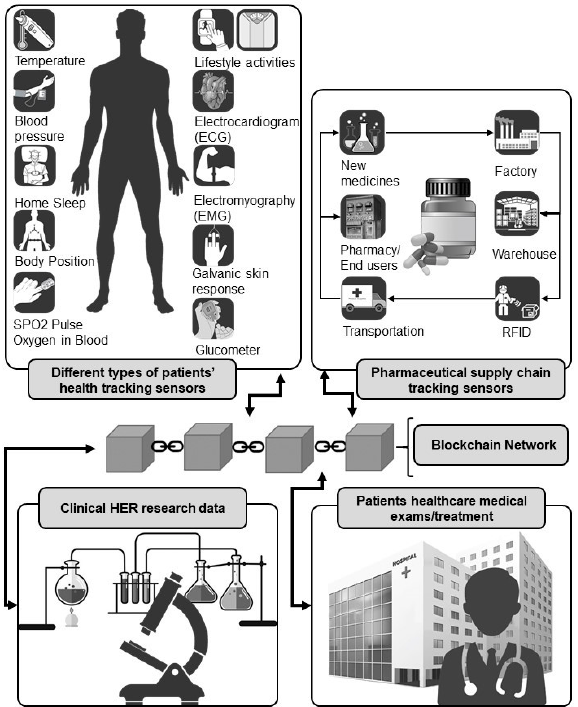
Figure 1. Blockchain use cases in Internet of Medical Things (IoMT).